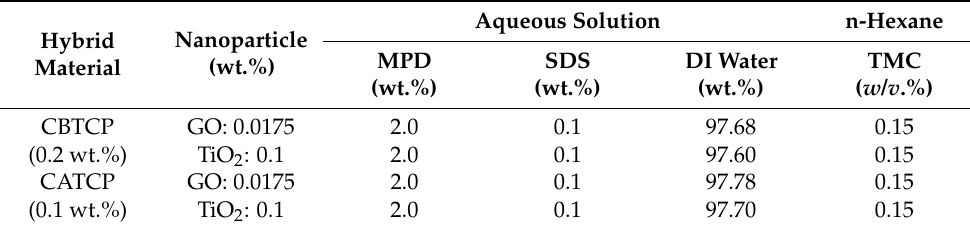
Table 2. Experimental conditions of the PA layer of the TFN membranes with additional dosage of GO or TiO 2 . Aqueous Solution n-Hexane Nanoparticle Hybrid MPD (wt.%) Material (wt.%)